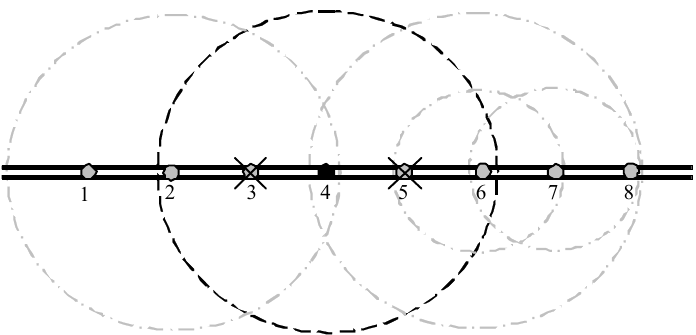
Figure 3. Automatic wireless/acoustic